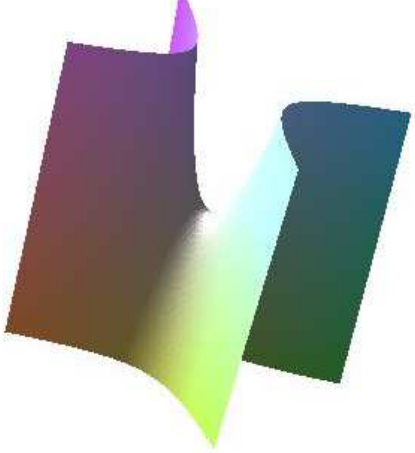
Figure 7. Graphic demonstration for Example